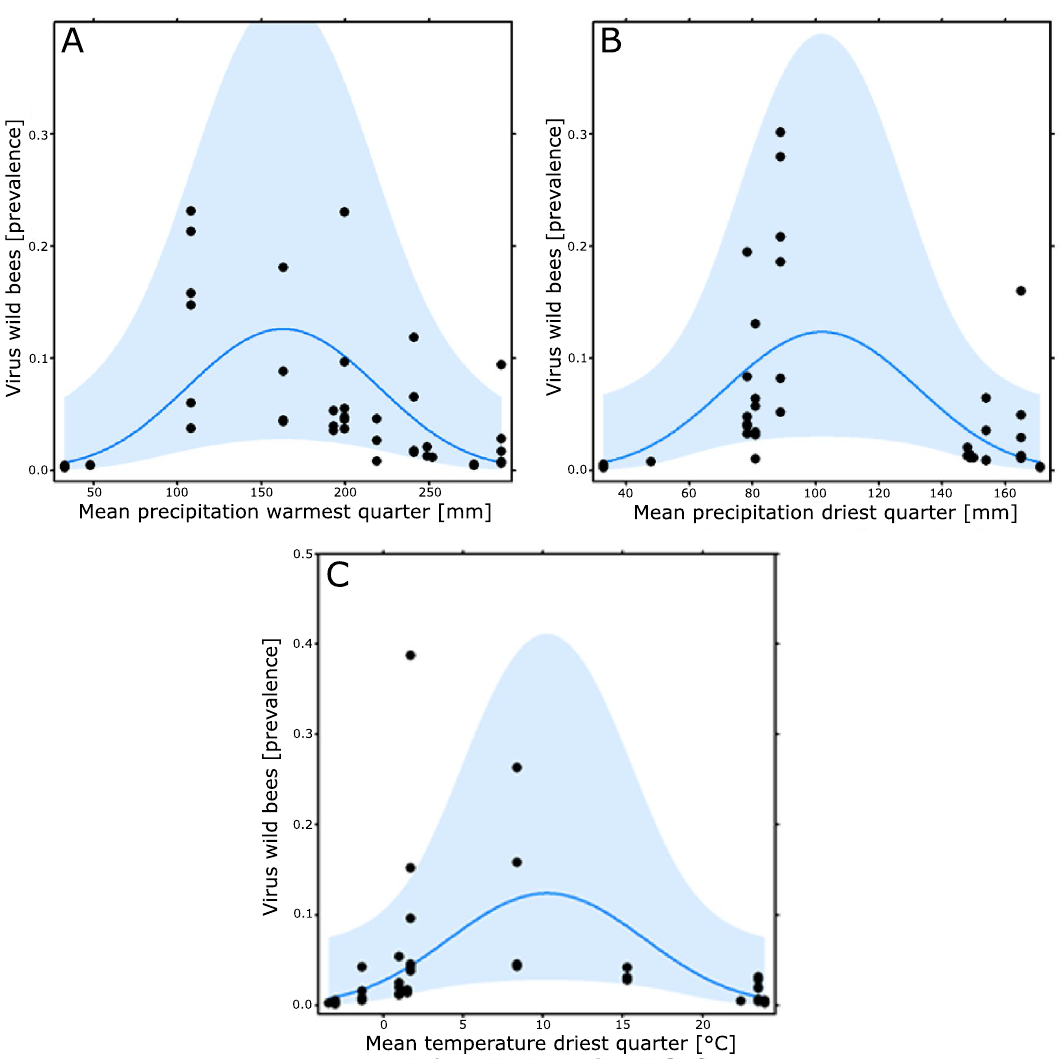
Figure 3. Relationship between viral prevalence (all viruses together) in wild bees (y- axis) and mean precipitation of the warmest quarter ( A ), mean precipitation of the driest quarter ( B ) and mean temperature of the driest quarter ( C ). Analysis indicated that the viral prevalence in wild bees was significantly affected by these three climatic variables. Precipitation and temperature means were obtained over a period of more than two decades at a resolution of 1–3 km. Shaded blue indicates the 95% confidential